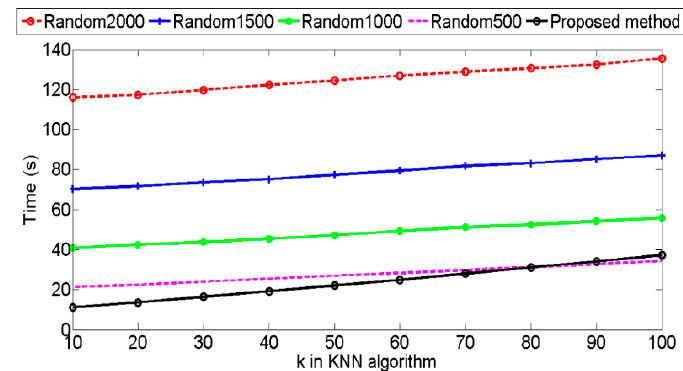
Figure 7. Processing time of the random methods and the proposed method.